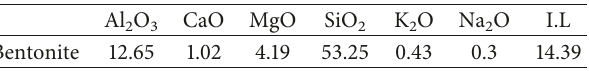
Table 3: Chemical component of bentonite